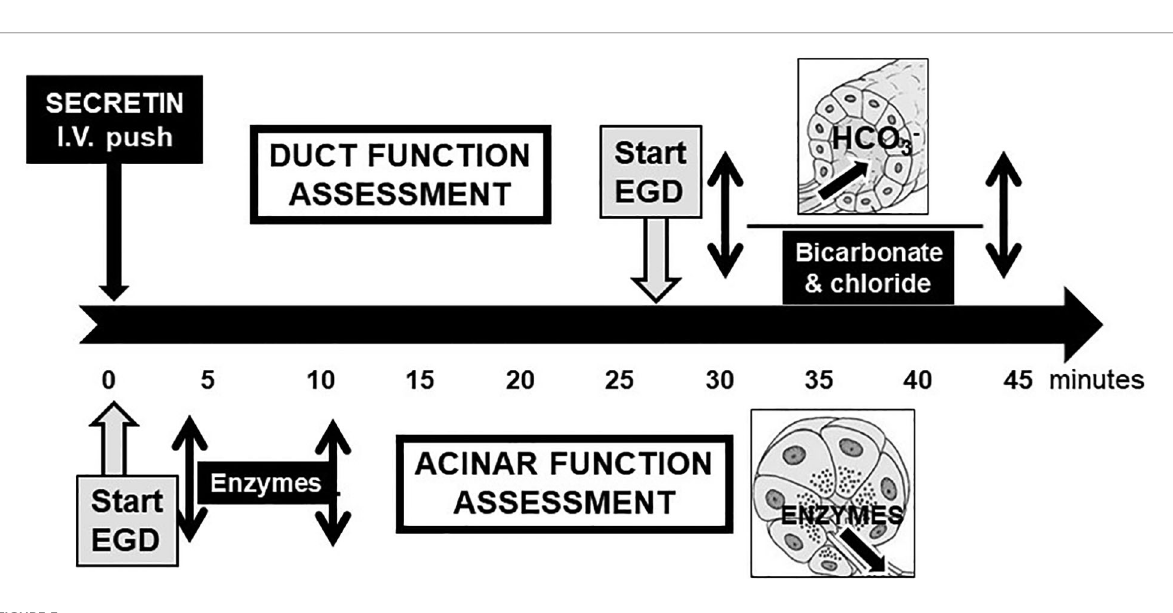
FIGURE 3 This fl owchart shows the optimal time of fl uid collection for acinar and ductal function after IV push administration of secretin [modi fi ed from Engjom, T. et al.